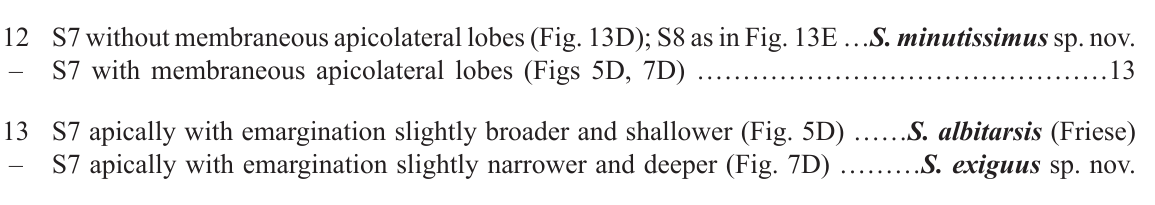
8 Hind tibia apically slightly swollen and curved (Fig. 29E); scutum between punctures smooth and shiny; S7 and S8 as in Fig. 29D, F ………………………………………… S. sittybon Davies – Hind tibia unmodified; scutum between punctures sculptured and matt ……………………………9 9 Basal half of T2–T4 densely covered with short, erect, silverish hair (Fig 33C); S7 and S8 as in Fig. – Basal half of T2–T4 almost hairless (Figs 17C, E, 20C) …………………………………………10 10 Discs of metasomal terga impunctate, very finely and regularly sculptured (Fig. 20C); S7 and S8 – Discs of metasomal terga partly punctate, strongly to heavily and irregularly sculptured (Fig. 17C, E); S7 and S8 as in Fig. 17D, F …………………………………………… S. nanus sp. nov. 11 Hind tibia yellow with a brown spot on the back side (Fig. 9A, C); S7 and S8 as in Fig. 9D–E